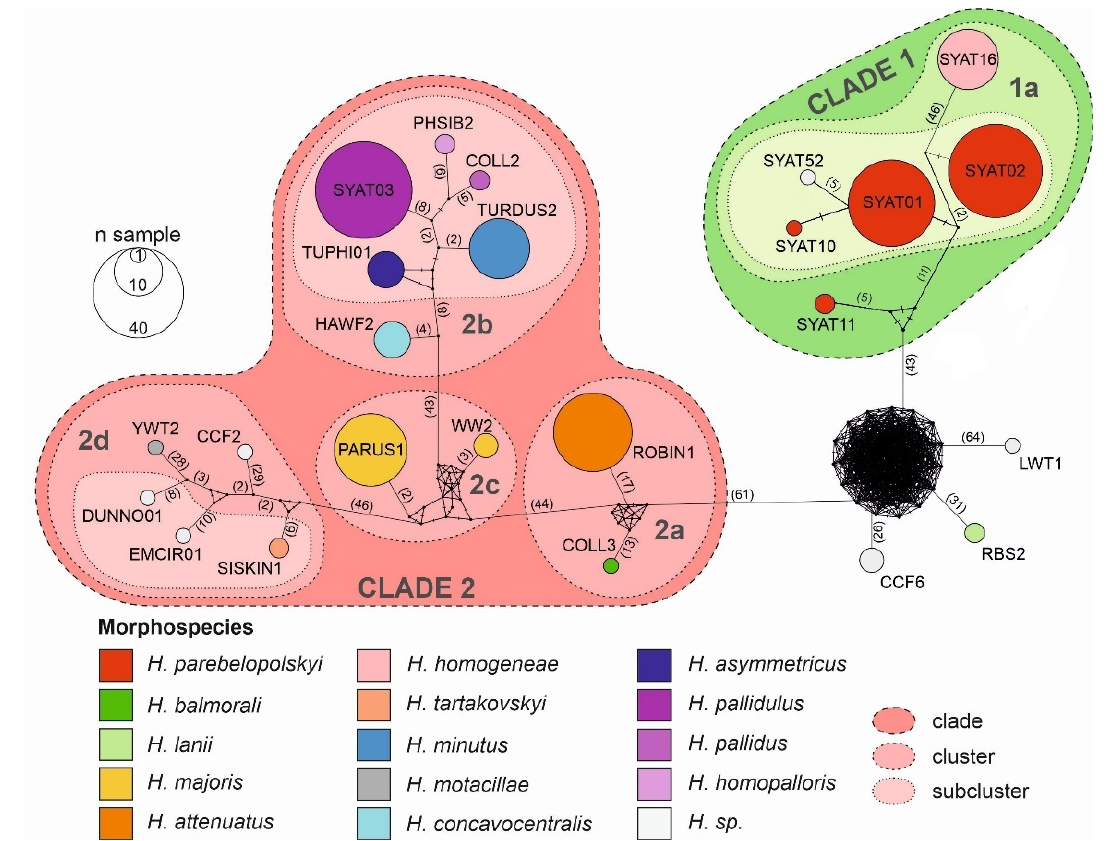
Figure 4. Haplotype network of avian haemoproteid lineages detected at the study site in Slovakia based on a 1516 bp mtDNA region encompassing the cytb gene. The haplotype network was con- structed using the median-joining algorithm. The borders of lineage clades, clusters, and subclusters were delineated based on phylogenetic analysis. Haemoproteid morphospecies are shown for the corresponding lineages.